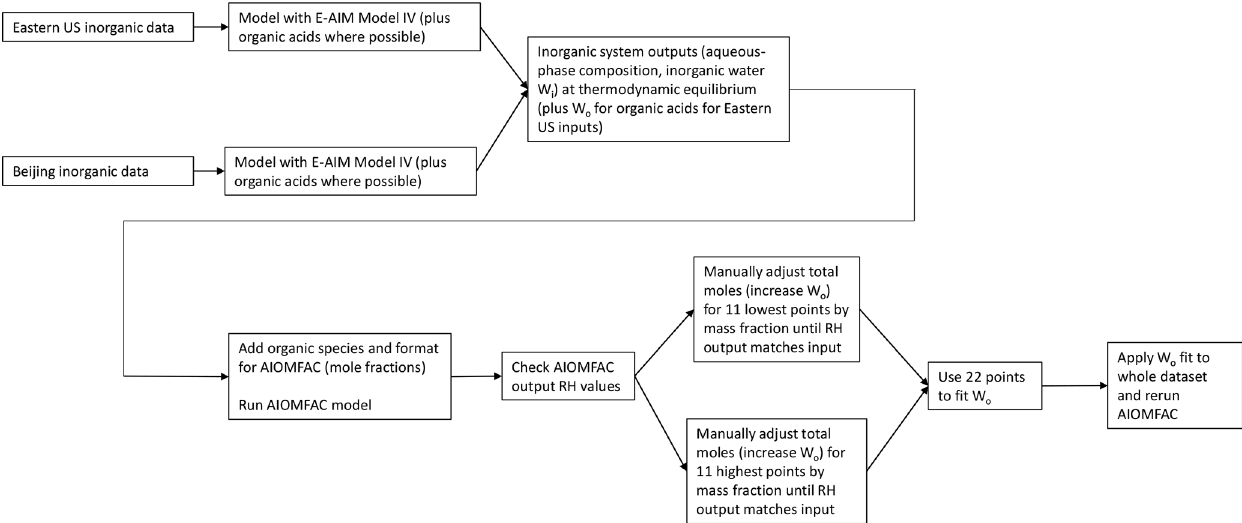
Figure 1. Flow diagram for adjusting total moles in the organic–inorganic mixed system inputs for the AIOMFAC model. Total moles were adjusted (representing increased W o ) by the first 11 and last 11 model points until the AIOMFAC-output RH was within 5% of the fixed model input value (70%, 80%, or 90%). These 22 points were then used to fit a polynomial function to correct the total system moles for the remaining 1309 data points. Table 2. Whole species inorganic inputs used in AIOMFAC modeling at 70%, 80%, or 90% RH. Inorganic equilibrium outputs were used to assign anions to cations to form whole species, represented here. Entries marked with a dash represent components not used for the given location as a result of the anion or cation not being present in the composition data (species not measured). Component Baltimore conc. Baltimore conc. Baltimore conc. Beijing conc. Beijing conc. Beijing conc. (molm − 3 ) (molm − 3 ) (molm − 3 ) (molm − 3 ) (molm − 3 ) (molm − 3 ) 70% RH 90%